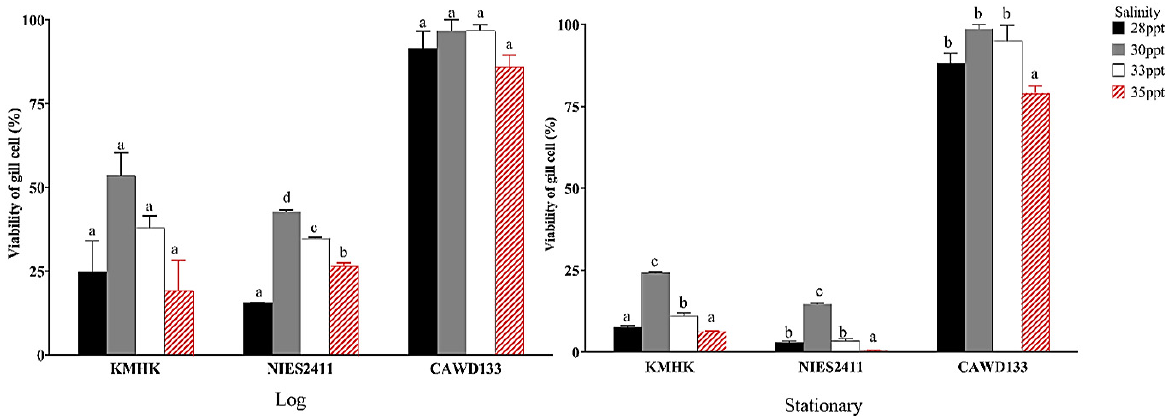
Figure 7. Ichthyotoxicity of three K. mikimotoi strains (KMHK, NIES2411 and CAWD133) grown in different salinities (28 to 35 ppt) under log phase ( left ) and stationary phase ( right ). The initial algal cell density of K. mikimotoi was 4 × 10 4 cells mL − 1 and the corresponding days for harvesting the algal cells of each strain at different growth phases were listed in Table A2. Small letters (a, b and c) indicate a significant difference in viability of gill cell at different salinities within a strain of K. mikimotoi . Non-toxic algal species Dunaliella tertiolecta (STK-2) was used as control and no mortality of the gill cells was observed within the 120 min exposure. Each bar represents the mean ± standard error of mean (SEM) of three true replicates. Small letters indicate a significant difference in salinities within a strain of K. mikimotoi